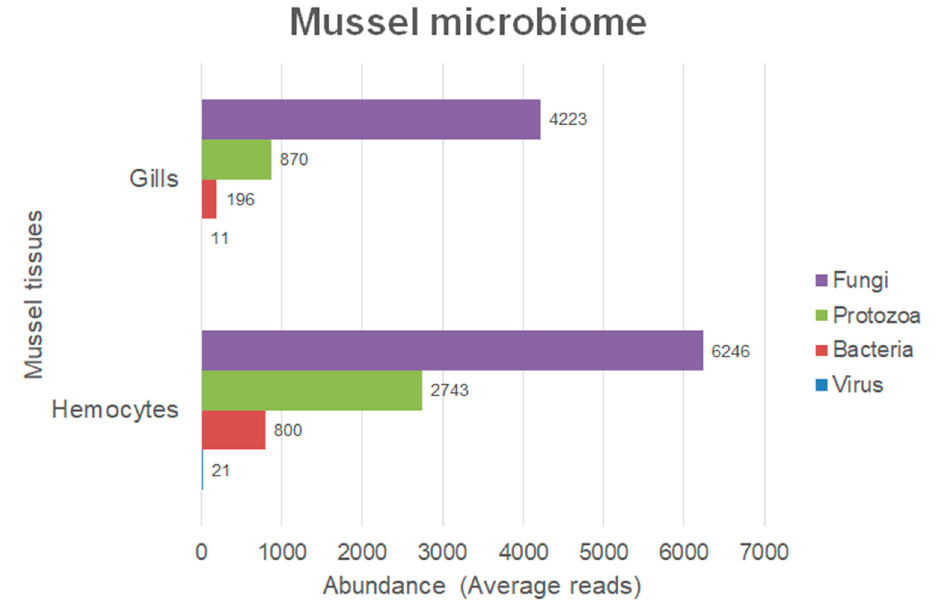
Figure 3. Microbiome comparison of the gills/haemocytes of M. galloprovincialis . Numbers indicate the quantity of reads that mapped in each group (on average, 3 individuals in gills and 6 in haemocytes).